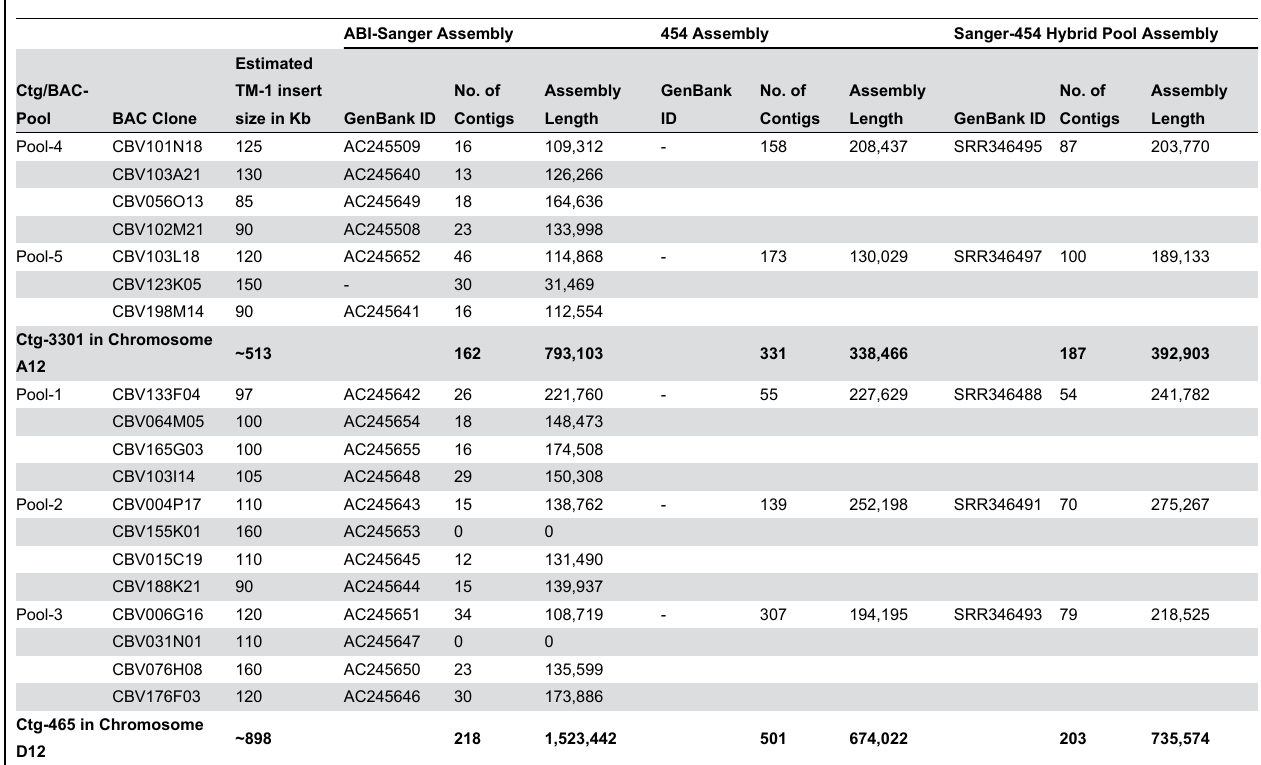
Table 1. Summary of 454, ABI-Sanger and hybrid assemblies for Ctg-465 and Ctg-3301 in